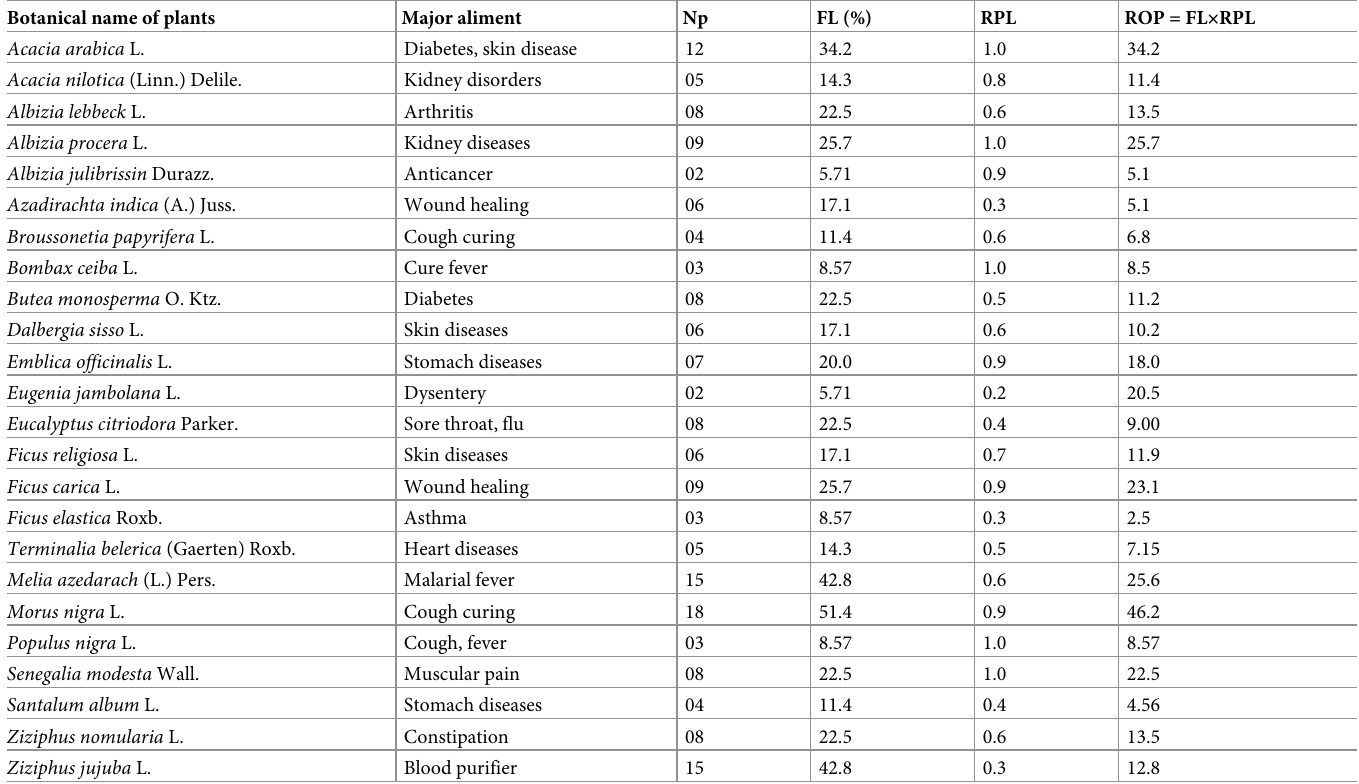
Table 7. List of ethnobotanical data of indigenous plants depicting highest uses values by FL, RPL, ROP from SMR District Bhimber AJK, Pakistan. Botanical name of plants